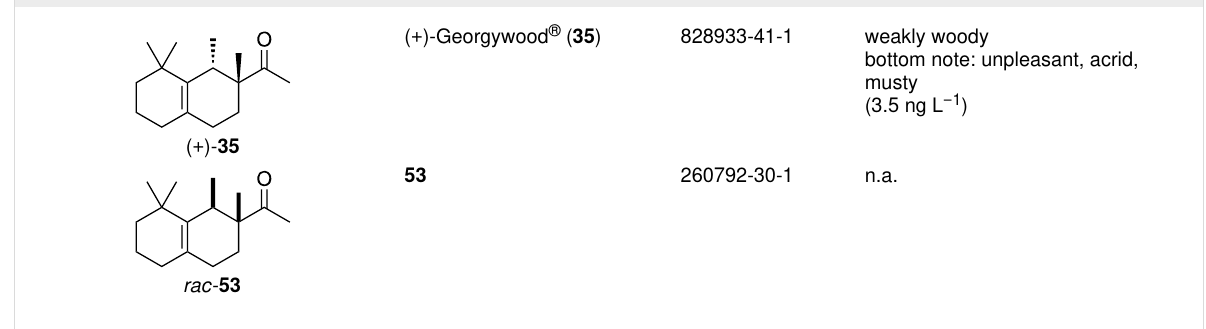
Table 1: Individual components of the complex Iso E Super ® mixture. (continued)